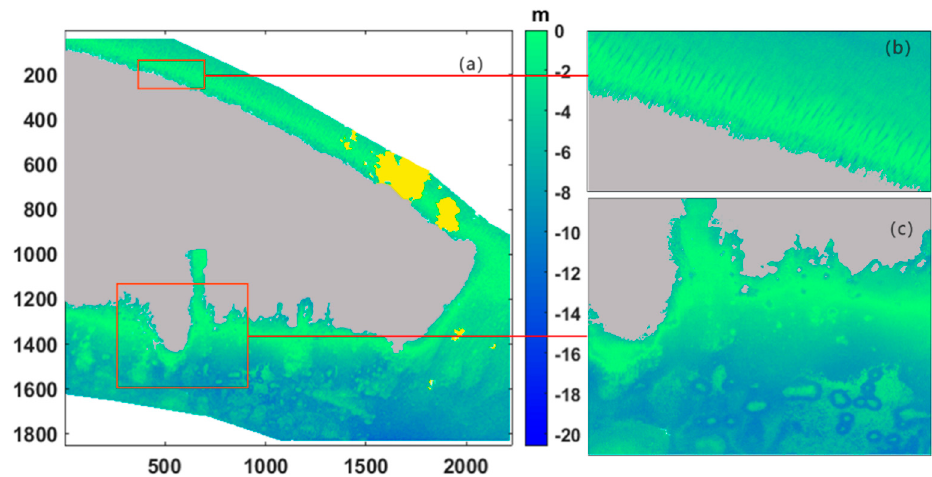
Figure 6. Bathymetric map of ( a ) Ganquan Island and ( b , c ) local details.